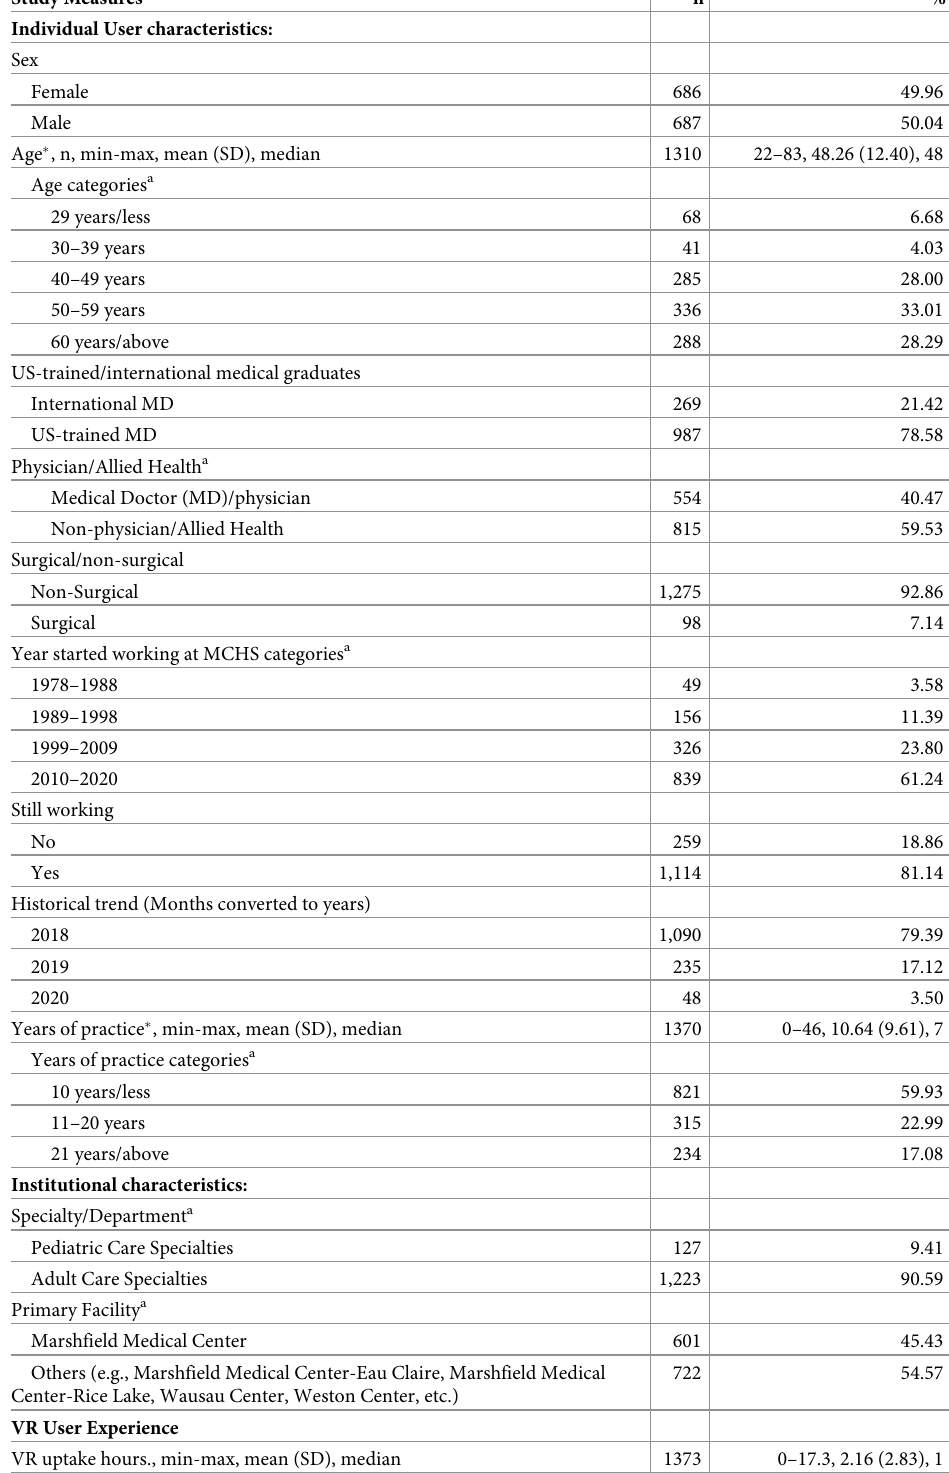
Table 1. User and institutional characteristics of MCHS providers, 2018–2020, N =